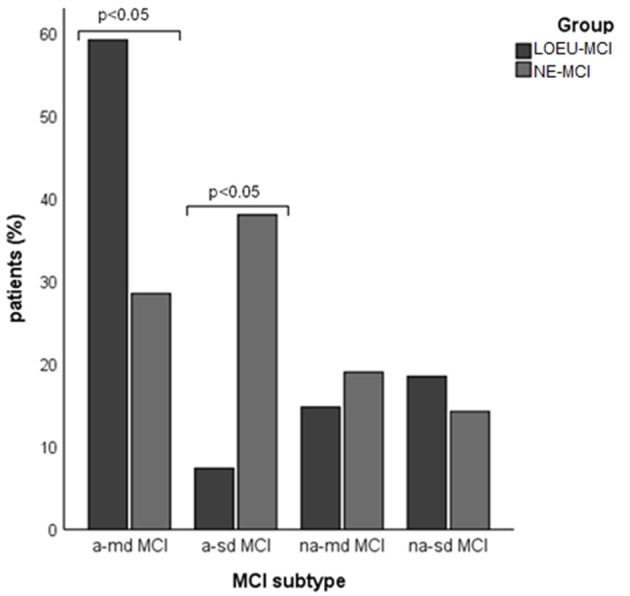
Distribution of mild cognitive impairment (MCI) subtype across groups. a-md MCI, amnestic multi-domain MCI; a-sd MCI, amnestic single-domain MCI; LEOU, late onset epilepsy of unknown etiology; NE-MCI, non epileptic-mild cognitive impairment; na-md MCI, non-amnestic multi-domain MCI; na-sd MCI, non-amnestic single-domain MCI.